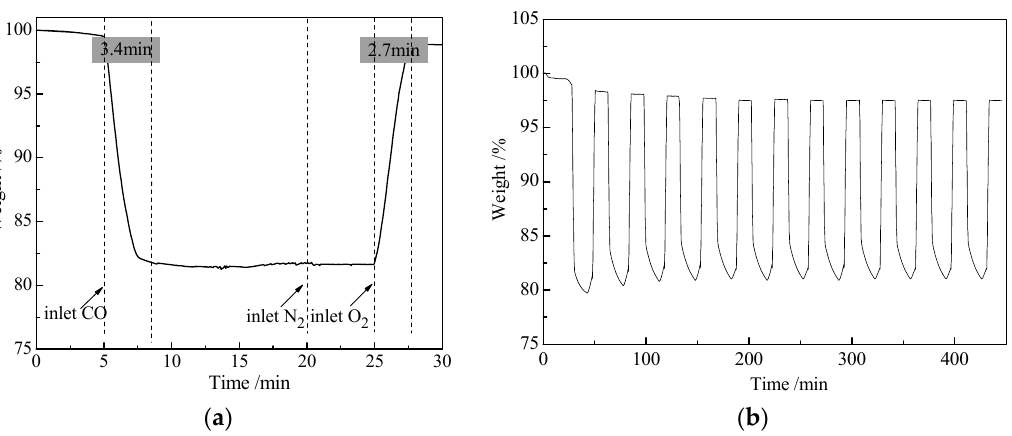
Figure 6. Redox cycle experiment for chemical looping combustion (CLC) of CO with Fe 2 O 3 (104)/Al 2 O 3 . ( a ) one cycle; ( b ) 12 cycles.